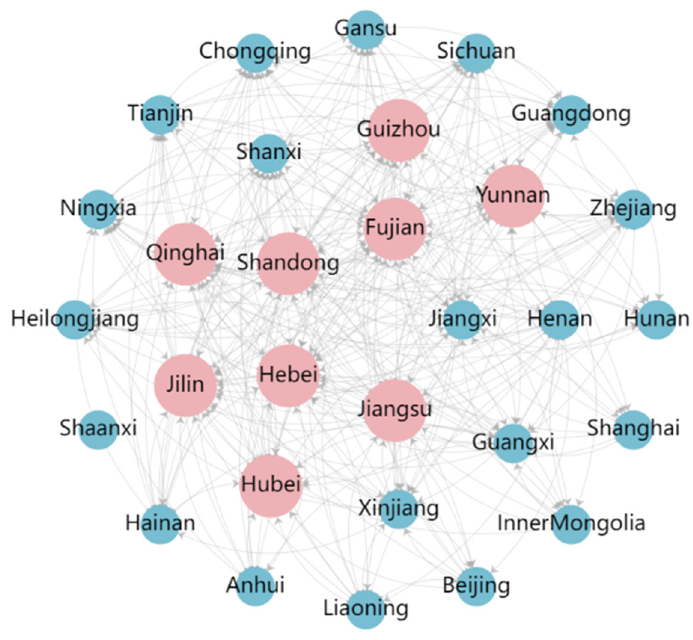
Figure 9. Network diagram corresponding to closeness centrality.